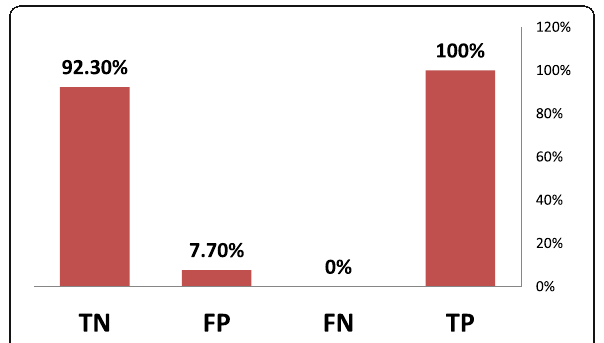
Fig. 5 Association between ultrasound findings and final diagnosis